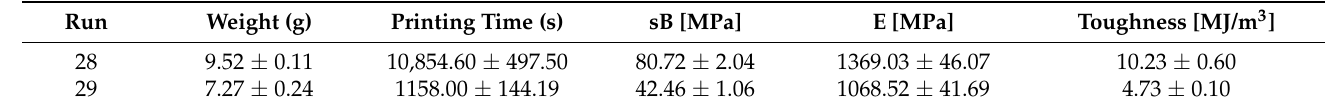
Table 6. Mean average values and standard deviations of measured responses for weight, printing time, compressive strength, compressive modulus of elasticity, and compressive toughness for the confirmation runs.